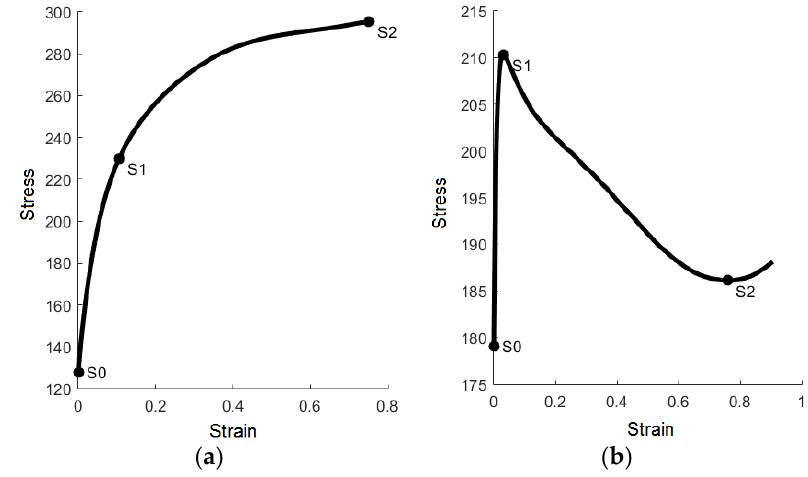
Figure 1. Plot with the types of cases under consideration: ( a ) growing curve, typical for materials deformed at room temperature (Case 1); and ( b ) decreasing curve, typical for previously ECAP-processed materials deformed at temperature values higher than 150 ◦ C (Case